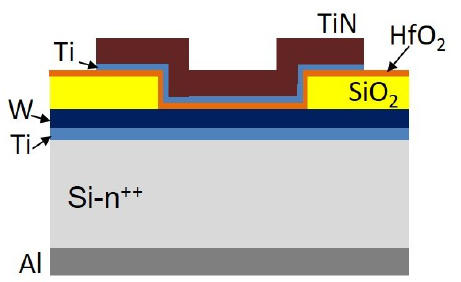
Figure 1. Cross-section picture of our resistive switching